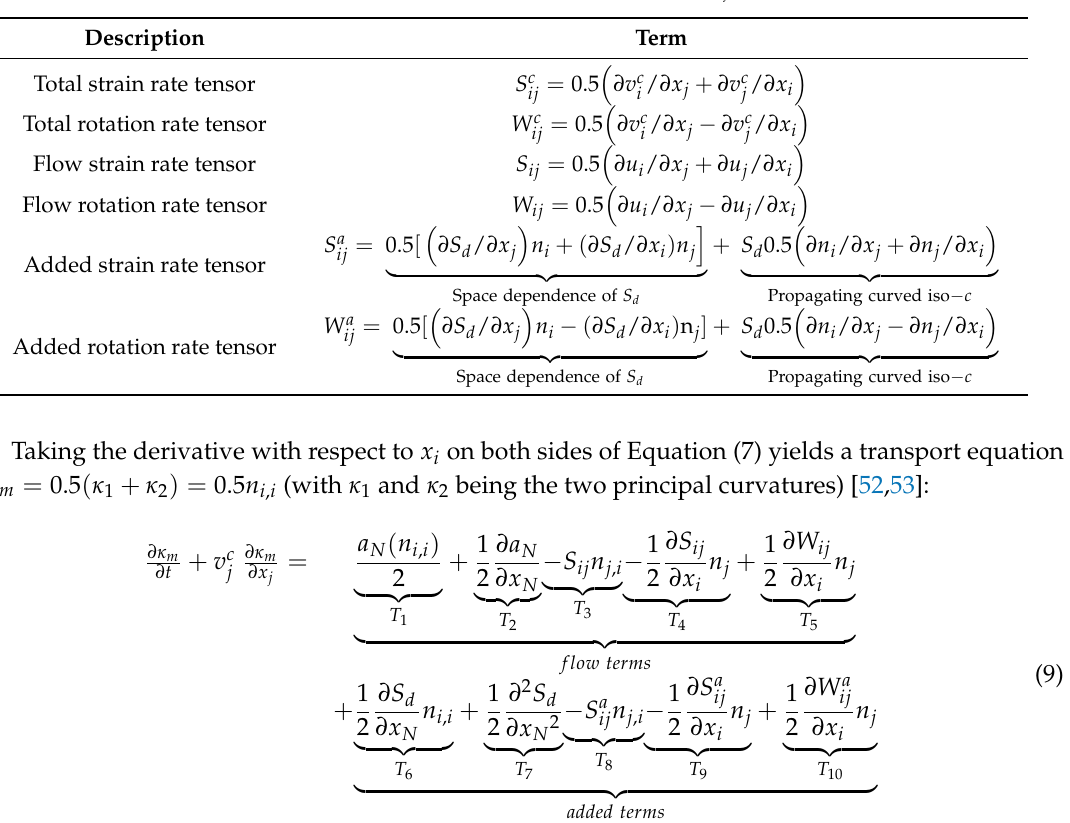
Table 1. Nomenclature associated with the velocity gradient tensor v c